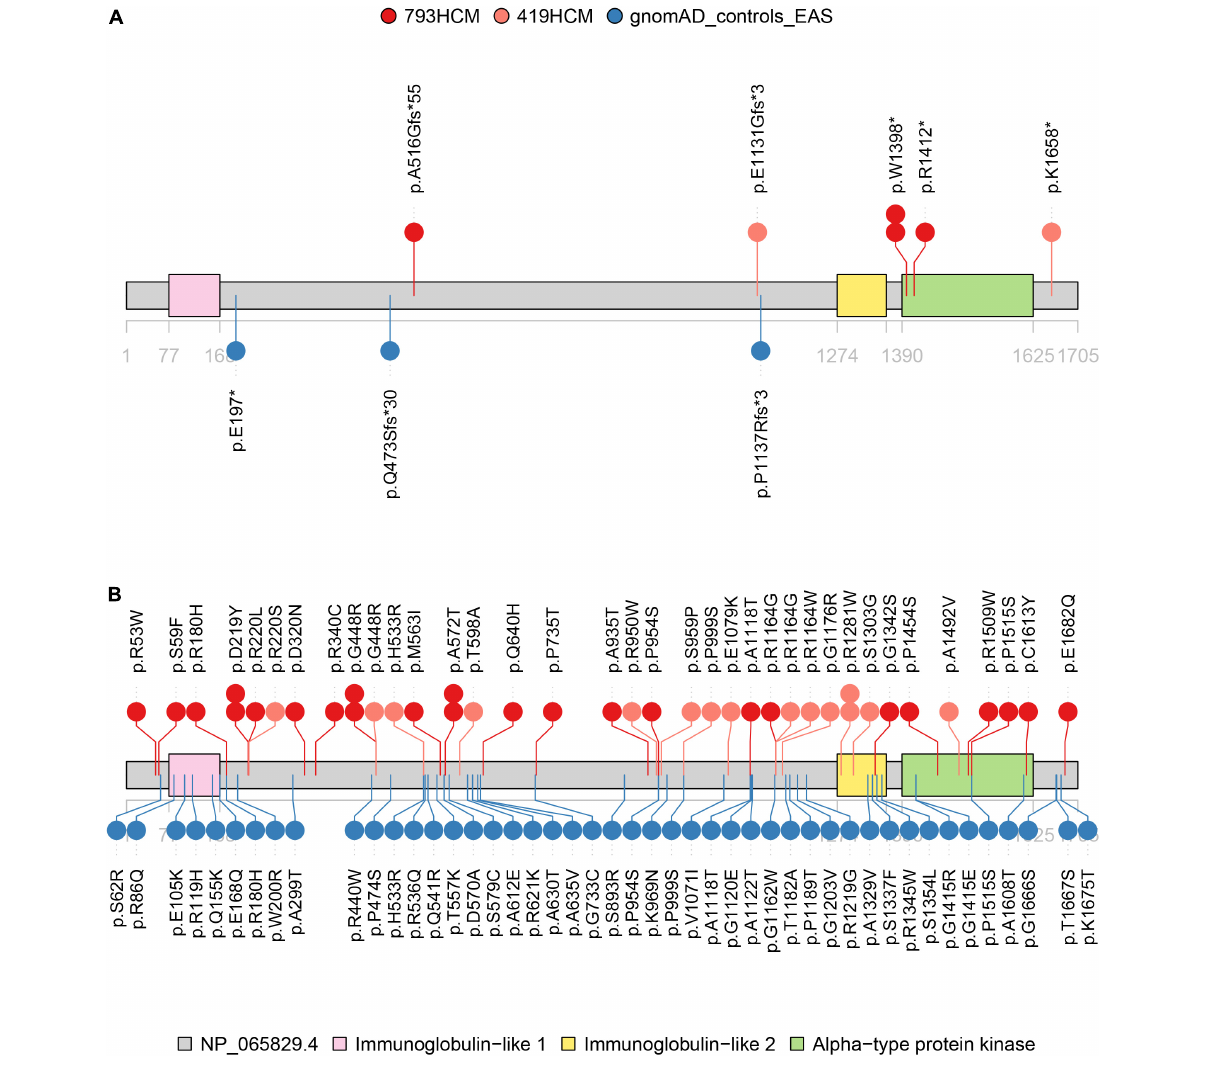
FIGURE 1 | Distribution of rare variants in ALPK3 . Structural and functional domains of ALPK3 protein showing variant sites identified in study cohort (red), validation cohort (pink), and gnomAD controls (blue). (A) Distribution of rare truncating variants (frameshift and stop-gained). Another two splice site variants, respectively, observed in one HCM case (NM_020778.5: c.4410 + 1G > C) of the validation cohort and one control (NM_020778.5: c.4773-1G > C) were not displayed. (B) Distribution of rare missense